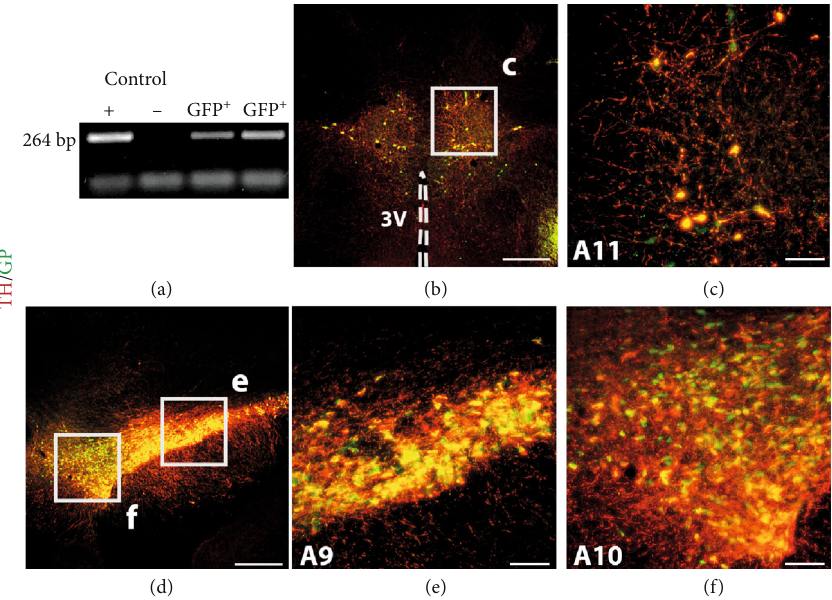
Figure 5: Characterization of an hTH-eGFP transgenic rat line. (a) An electrophoresis image shows the genotyping results of hTH-eGFP pups. From left to right, loading samples are ampli fi ed PCR products of the GFP + breeding colony (positive control, +; lane 1), wild type rats (negative control, -; lane 2), and testing samples (lanes 3-4). (b – f) Colocalization of TH and GFP in A9, A10, and A11 nuclei. Immunostaining shows GFP-tagged TH + neurons in the A11 (b, c), A9 and A10 nuclei (d – f). Scale bars: (b, d) 500 μ m; (c, e, and f) 100 μ m; V: